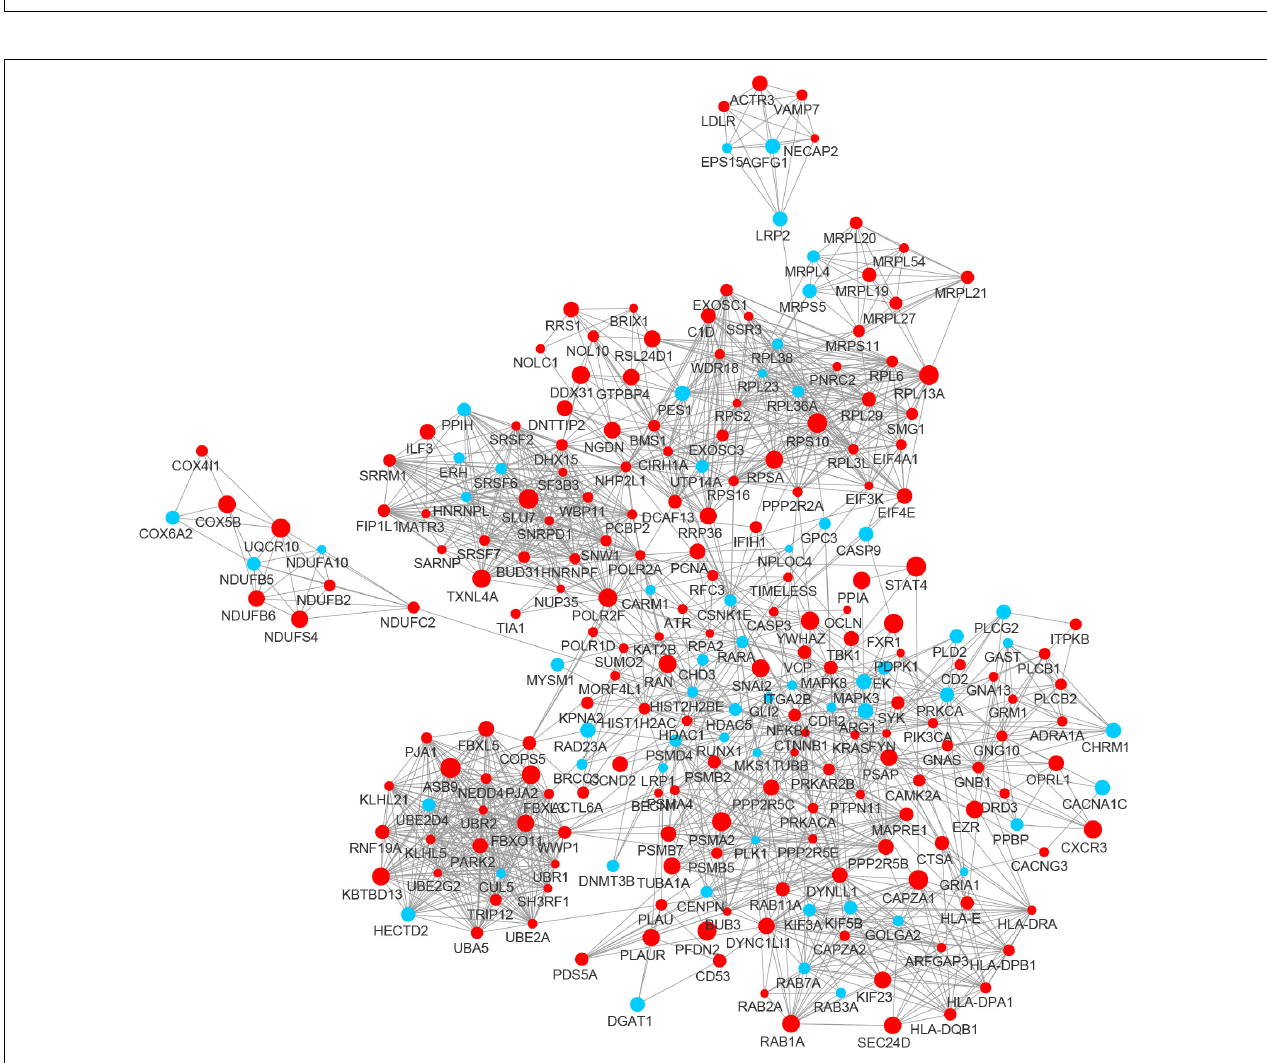
FIGURE 8 | The PPI network of the genes co-expressed with ACE2 in lung. The nodes representing positively correlated genes are shown as red circles and the negatively correlated genes are presented as blue circles. The sizes of the nodes are illustrated from small to big in ascending order of correlation.